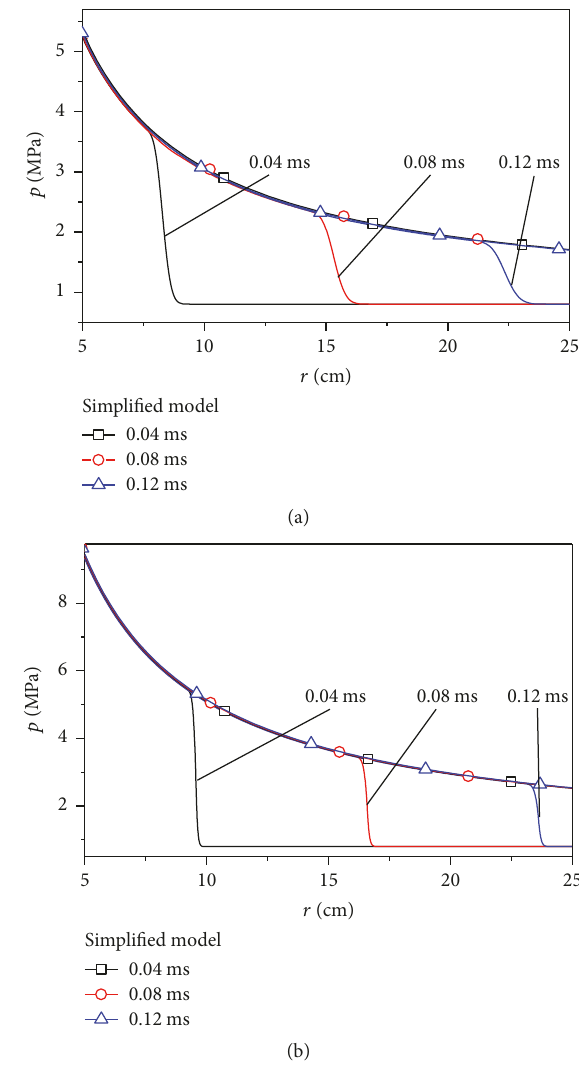
Figure 7: Comparison of pressure profiles predicted by the full (curves with times indicated) and simplified (curves denoted by symbols) models: (a) droplet radius 𝑅 = 13 mm; (b) 𝑅 = 25